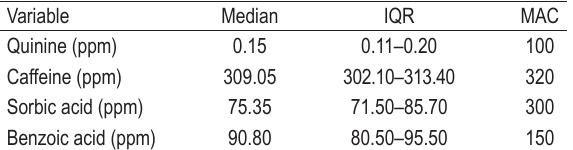
FIGURE 3: The sorbic acid content in energy drinks brands.